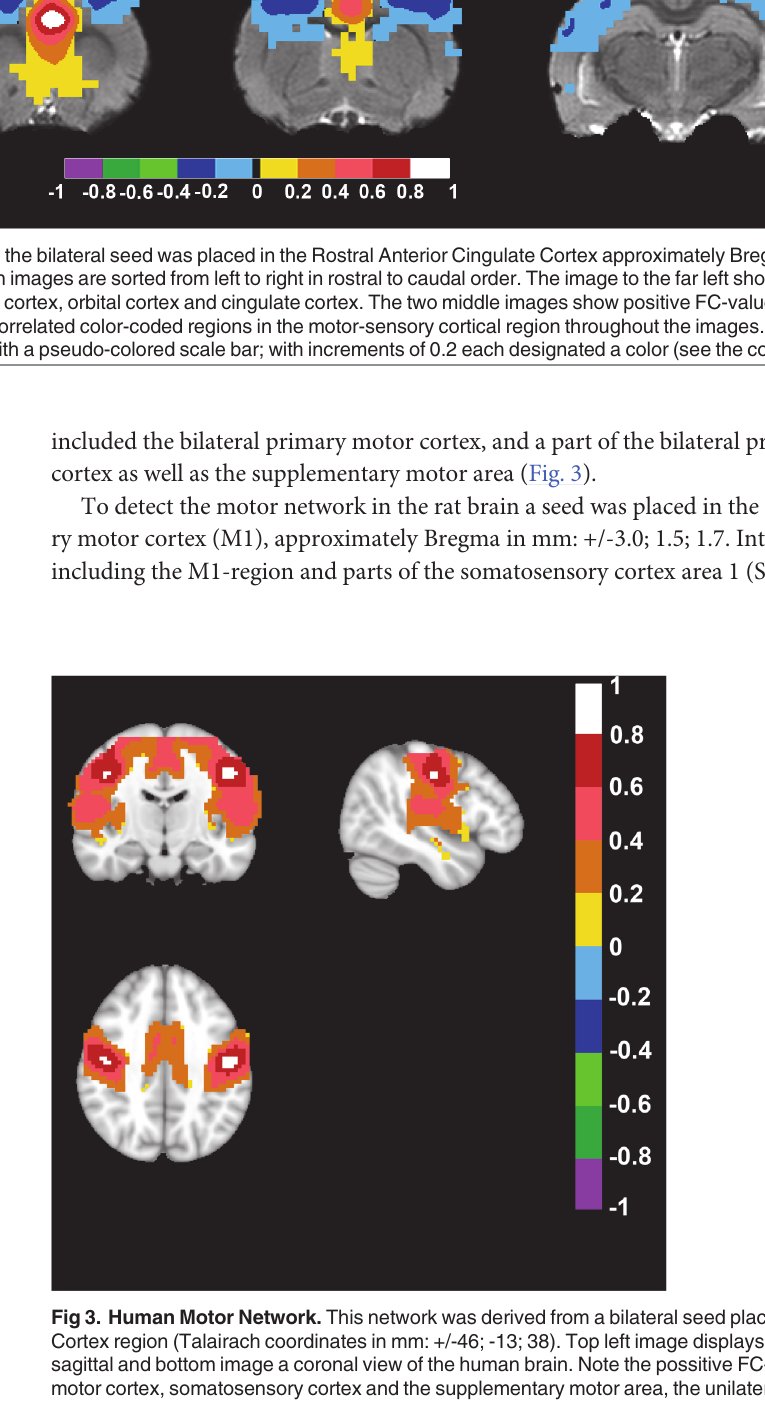
PLOS ONE | DOI:10.1371/journal.pone.0120345 March 19,